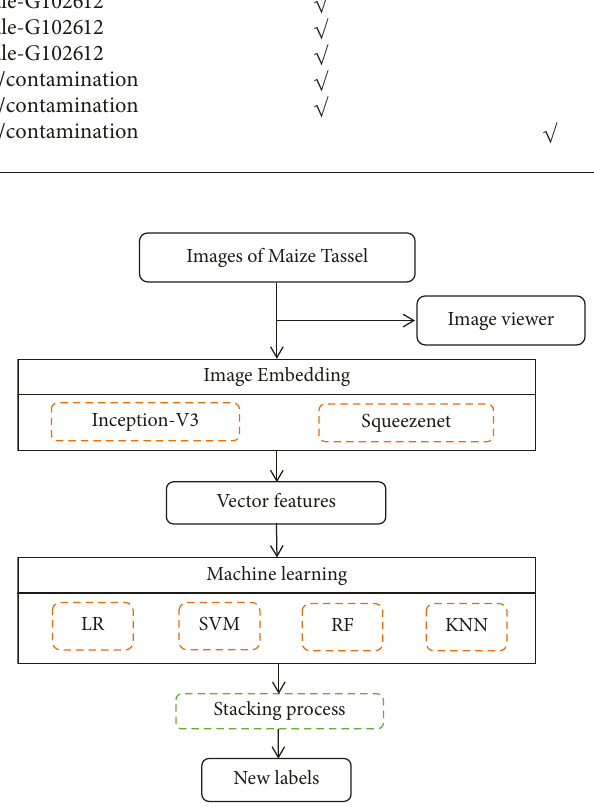
Figure 2: The overall framework for the detection of maize parental lines in this